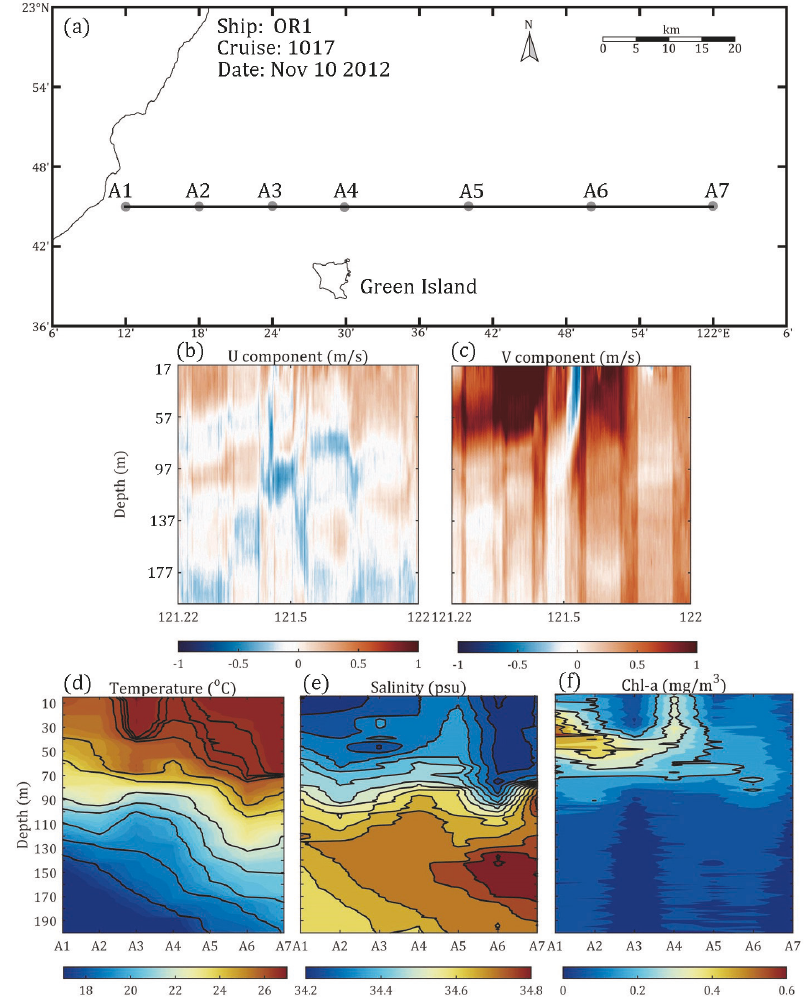
Figure 2. ( a ) The cruise experiment results with ( b , c ) velocity (U component positive in the east, V component positive in the north), ( d ) temperature, ( e ) salinity, and ( f ) Chl-a from stations A1 to A7 on 10 November 2012.